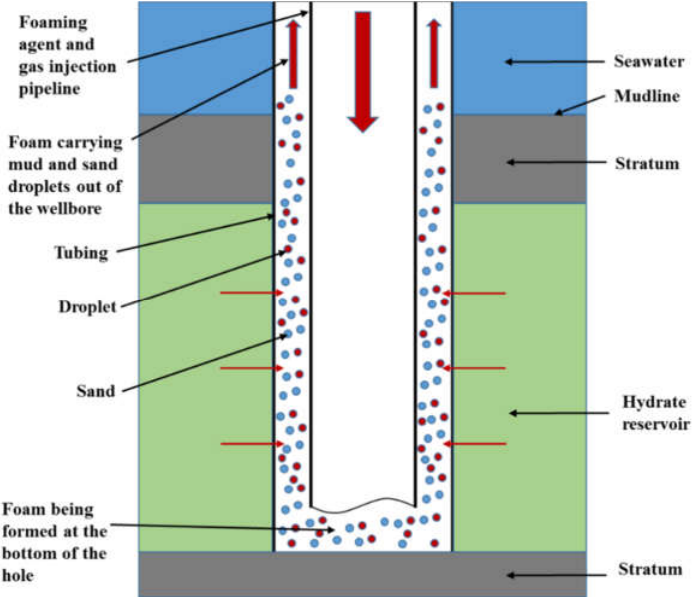
Figure 1. Foam drainage and gas recovery technology schematic diagram.